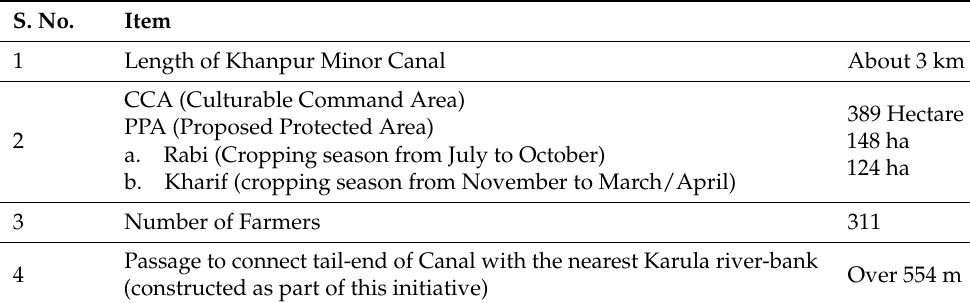
Table 1. The main features of the Khanpur Minor Canal System, including CCA (Culturable Com- mand Area, the area which can be physically irrigated from a scheme and is fit for cultivation) and PPA (Proposed Protected Area, the area that is assured for irrigation by a